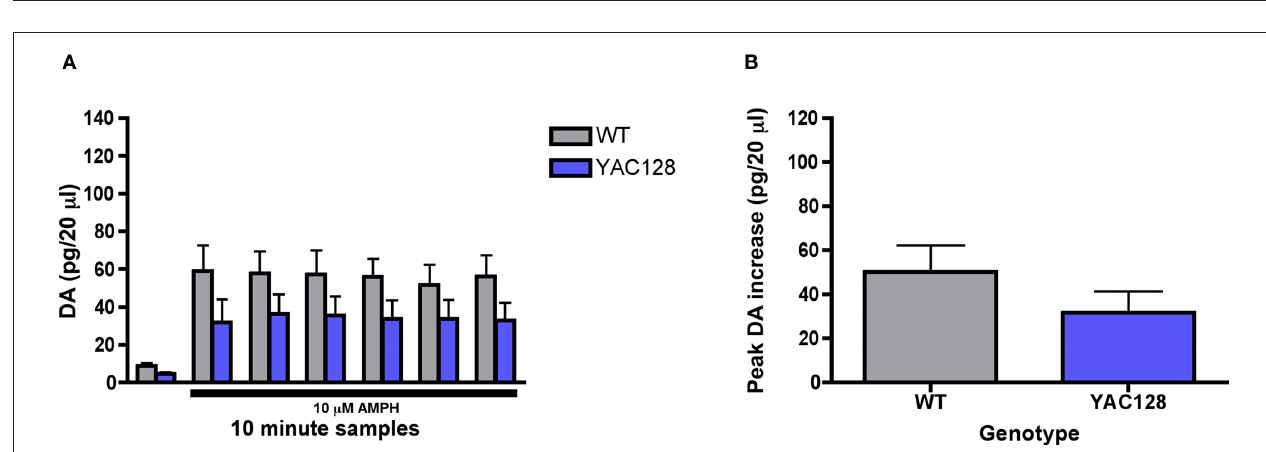
Figure 6 | effect of intrastriatal application of amphetamine (10 μM) on striatal (A) dopamine release and the (B) maximum peak increase in dopamine efflux in 9-week-old r6/2 transgenic mice ( n = 3 WT, 3 r6/2). Presence of amphetamine in perfusate is indicated by black bar. Data are picograms per 20 μl sample. All data are mean ± SEM. * Indicates significantly different from WT, P < 0.05; ** indicates P < 0.001; *** indicates P < 0.005.